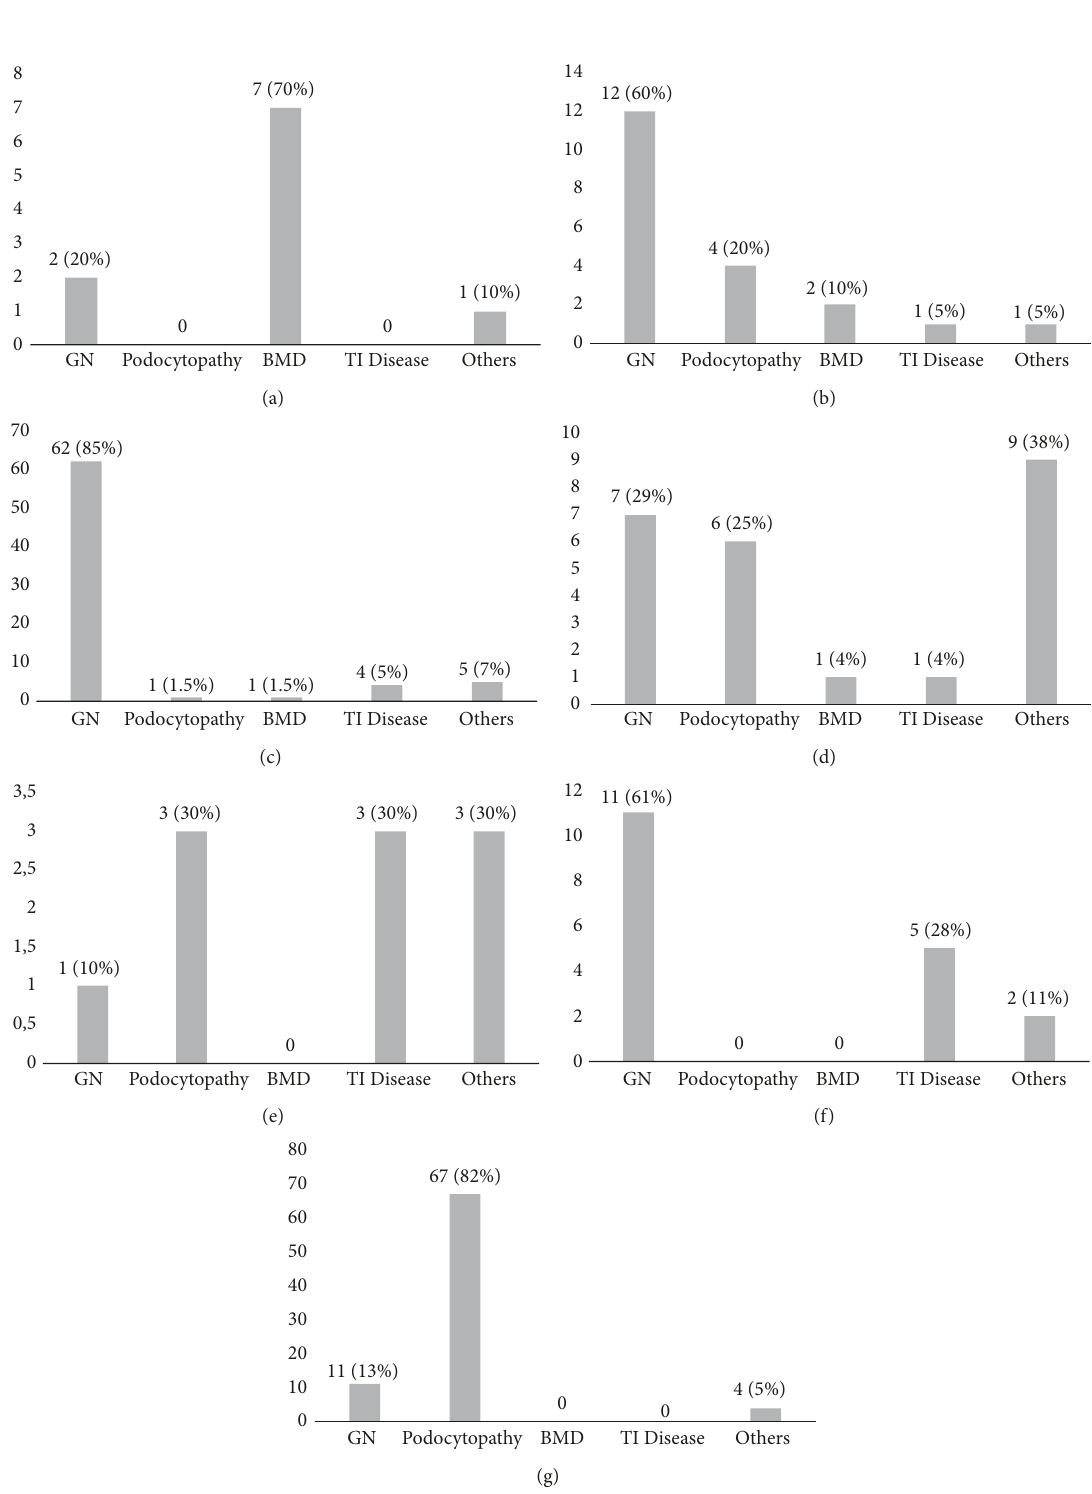
Figure 2: Renal biopsy indications and biopsy diagnoses. (a) Isolated hematuria; (b) proteinuria and hematuria; (c) systemic disease with renal involvement; (d) isolated subnephrotic proteinuria; (e) glomerular filtration rate impairment without a known cause; (f) nephritic syndrome; (g) nephrotic syndrome; GN: glomerulonephritis; TI: tubulointerstitial; BMD: basement membrane